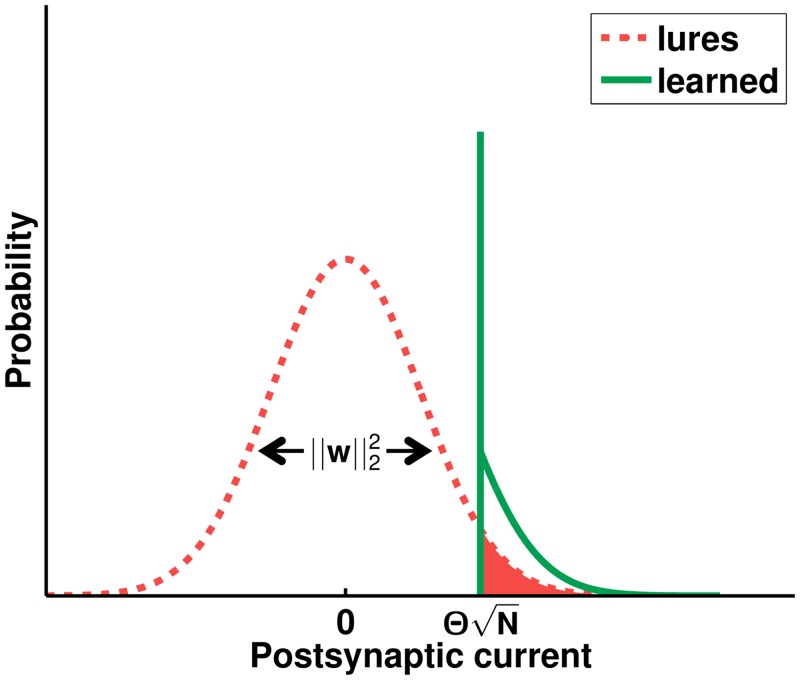
Schematic illustration of the postsynaptic current distributions.In the large N limit, the postsynaptic current elicited by lures (dashed line) is well described by a zero-mean Gaussian, whose variance ⟨δhl2⟩ is determined by the squared Euclidean norm ∣∣w∣∣22 of the weight vector. Assuming that the learning dynamics converged, the postsynaptic current distribution provided that the input pattern is a learned one (solid line) is characteristic of perceptron learning: a significant number of patterns lie on the decision boundary and thus provoke a current that is exactly at the firing threshold, while the remaining ones generate super-threshold Gaussian tail currents [28]. The integral of the shaded area gives the FP probability p
01, which depends on the variance of the lure current distribution.